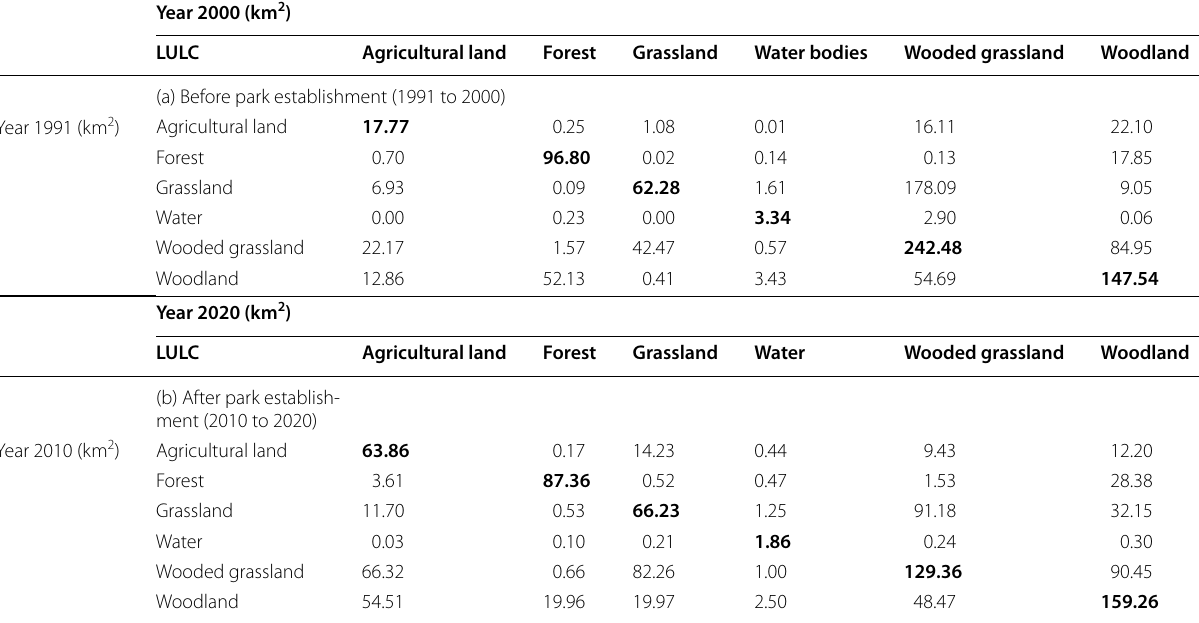
Table 6 Matrix of land use and land cover change (in km 2 ) in the buffer zone of Chebera Churchura National Park (a) before establishment of the park (1991 to 2000) and (b) after establishment (2010 to 2020). Values in bold font indicate stable land